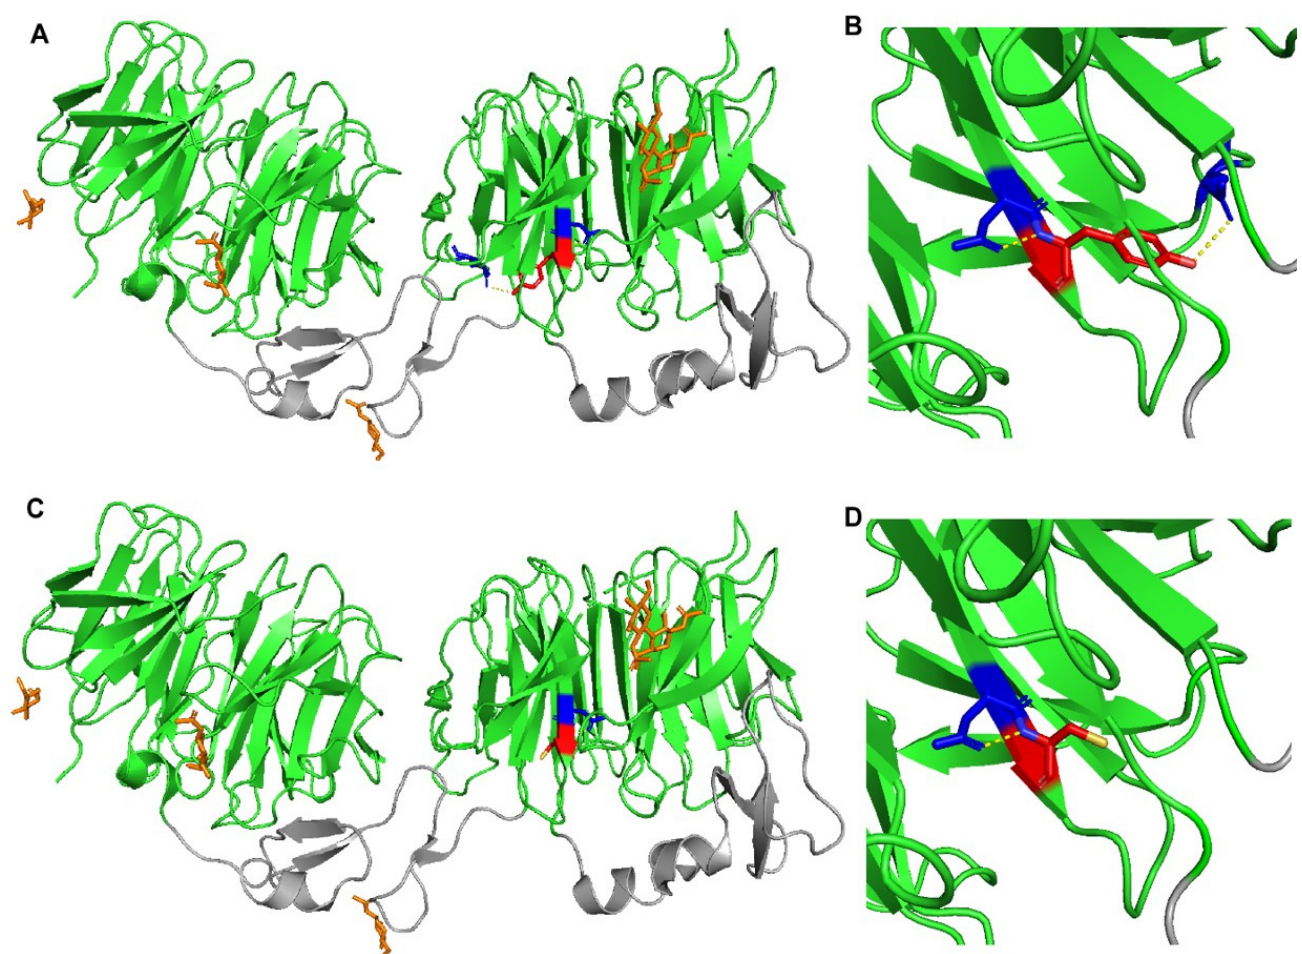
Figure 3. Crystal structure of wild-type and mutant LRP6-E3E4 with β -propeller domains (green) and epidermal growth factor (EGF)-like domains (gray) . ( A , B ) LRP6-E3E4 Tyr972 residue (red) has polar contacts (yellow dotted lines) with Asp971 and Glu993 (blue). ( C , D ) LRP6-E3E4 mutant Cys972 residue (red) has a polar contact (yellow dotted line) only with Asp971 (blue). 2.4. Bile Acid Synthesis Is Not Affected by the CYP7A1 Variant p.(Pro398Ala)